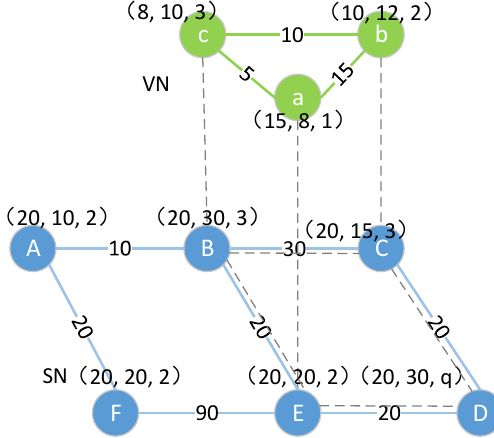
Figure 2. Example of VNE.